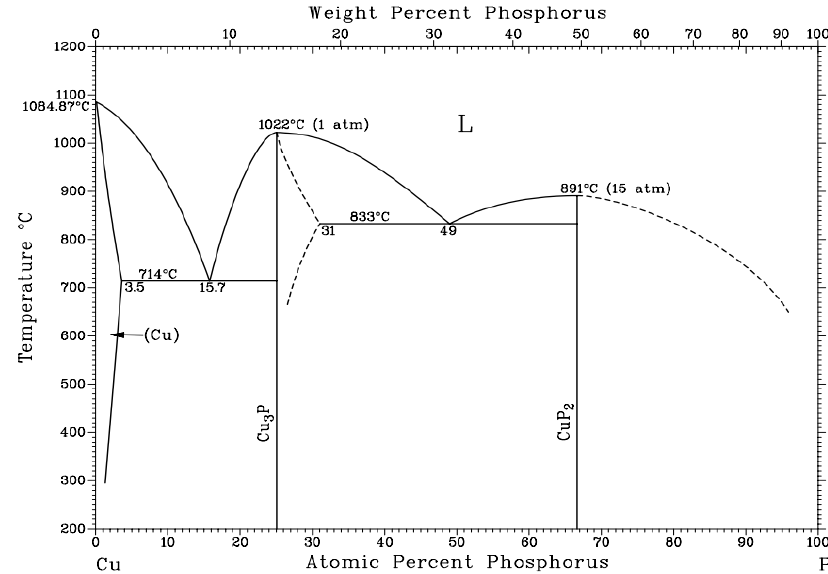
Figure 13. Cu-P phase diagram [19].